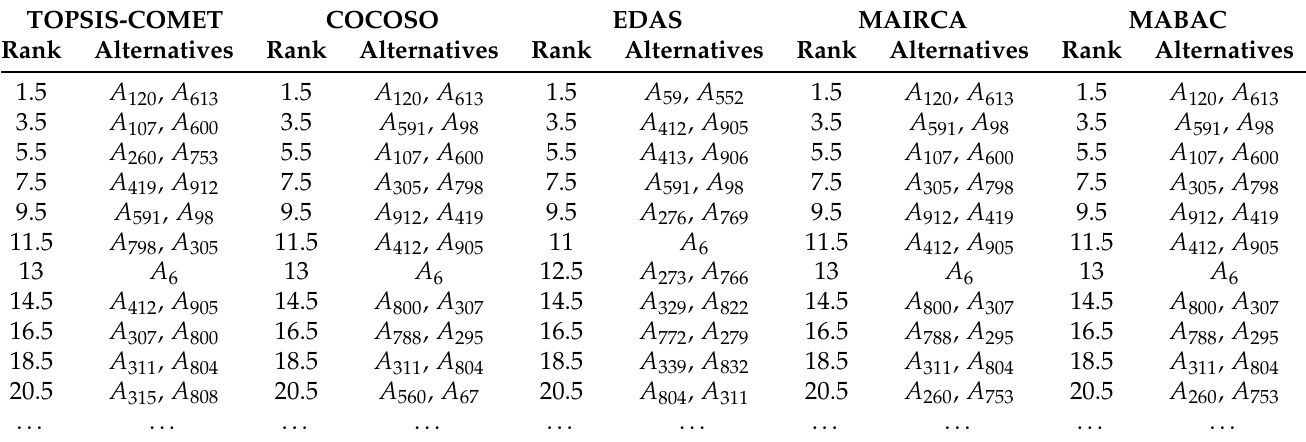
Table 15. Final rankings obtained with MCDM methods for the whole set of alternatives. TOPSIS-COMET